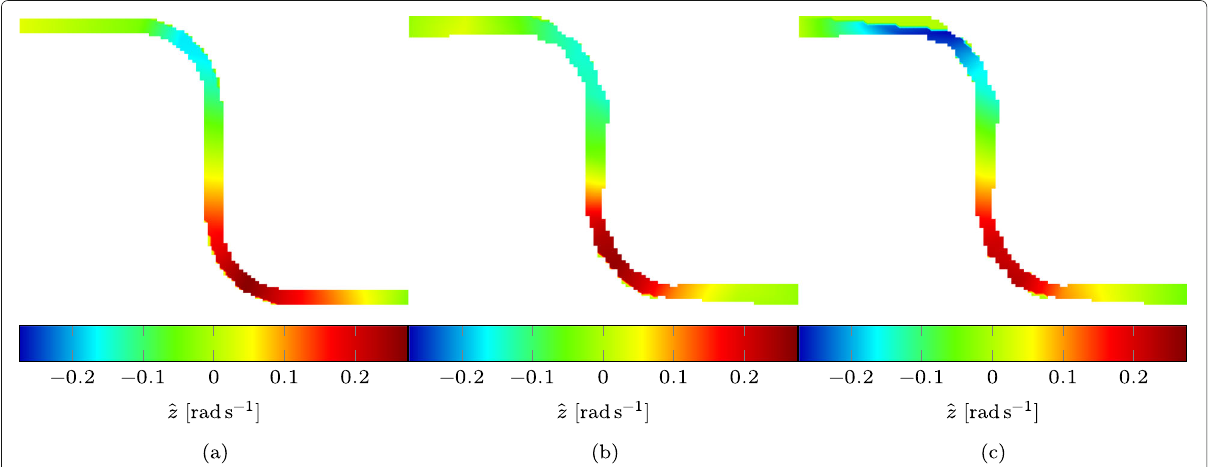
Fig. 14 Estimated RF values for L θ = 750, L = 316. Individual (i.e., non-averaged) results that have been selected for illustrative purposes are shown. The actual turn rate profile is given in Fig. 5b. a RFE = 6.70 × 10 − 3 rad s − 1 , σ EU = 0, l ϕ = 3.50 m. b RFE = 7.50 × 10 − 3 rad s − 1 , σ EU = 0.5, l ϕ = 2.50 m. c RFE = 9.21 × 10 − 3 rad s − 1 , σ EU = 0.5, l ϕ = 3.50